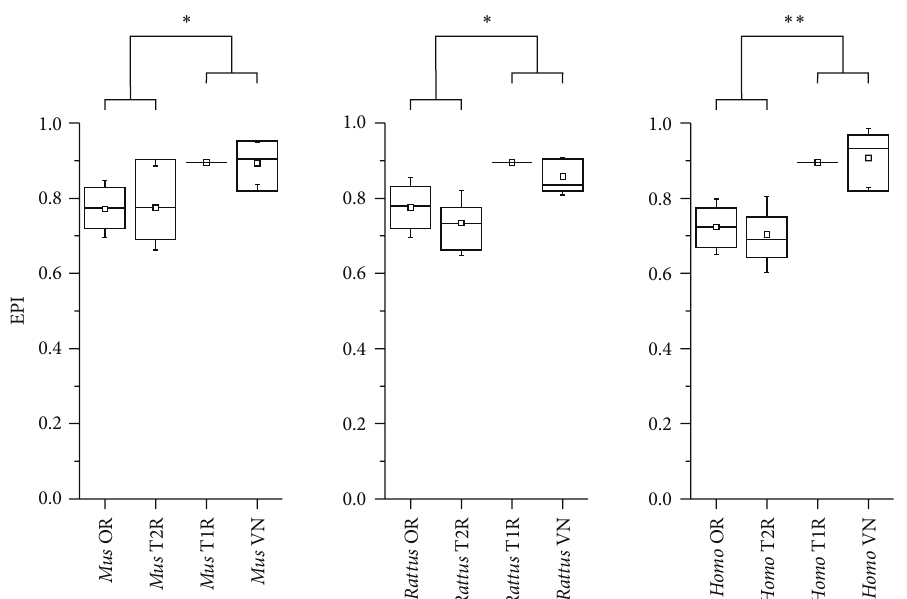
Figure 5: Mean EPI values of chemoreceptors families. Plasticity values are shown in the vertical axis and the different families are listed on the horizontal axis. The line at the center of each box indicates the median, the square represents the mean, and whiskers represent the standard deviation. Statistically significant data are indicated by double ( 𝑃 < 0.001 ) and single ( 𝑃 < 0.05 )